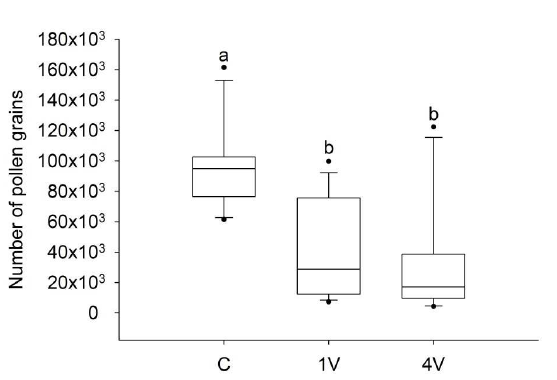
F IGURE 4. Mean number of pollen grains of tomato virgin flowers (C), of flowers visited once (1V) and four times (4V) by a forager of Bombus impatiens . Different letters (a, b) indicate statistical differences at P< 0.05 (Kruskall-Wallis, pair comparison: Dunn’s method). Box plots: box indicates the distribution of 50% of the values, horizontal full line indicates median, horizontal dashed line indicates mean, whiskers indicate standard error (above 90% and below 10%) and spheres indicate